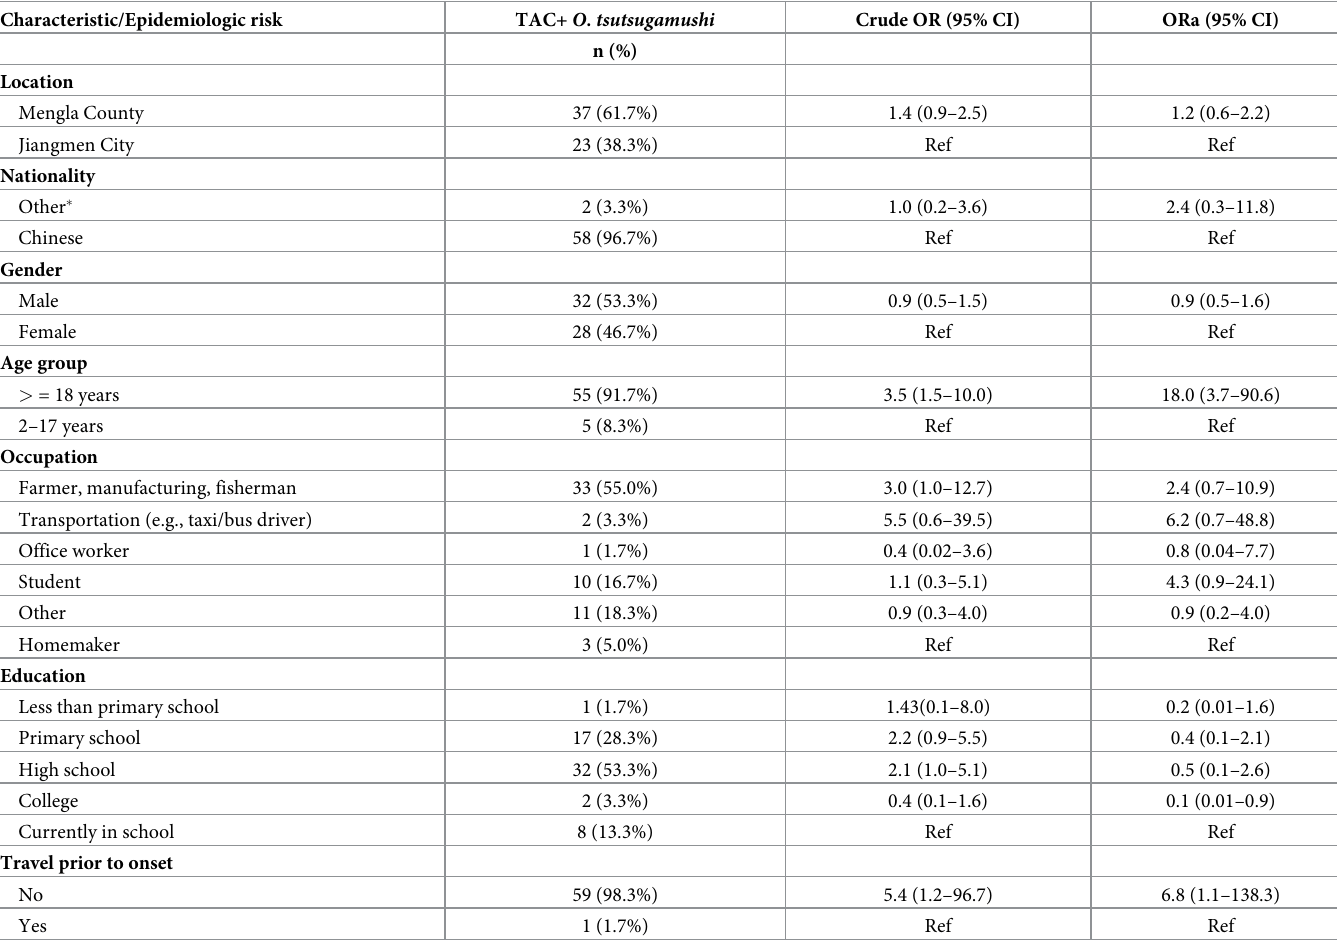
Table 5. Association between patient characteristics/epidemiologic factors and detection of Orientia tsutsugamushi on the TaqMan Array Card (TAC) � diagnostic testing platform, China, June 2017–July